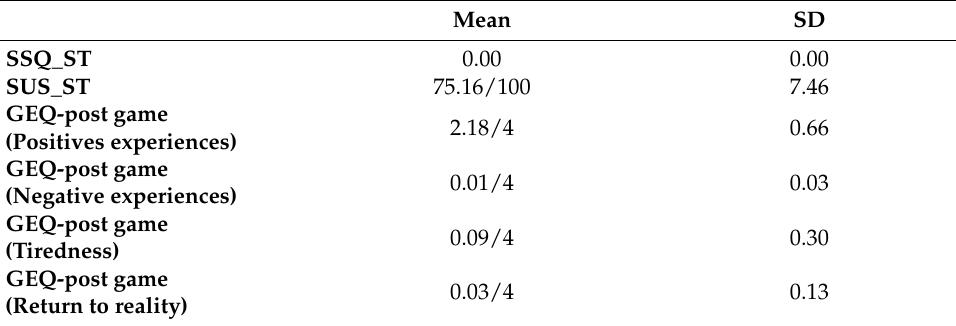
Table 2. Results of safety, usability, and post-game experiences.